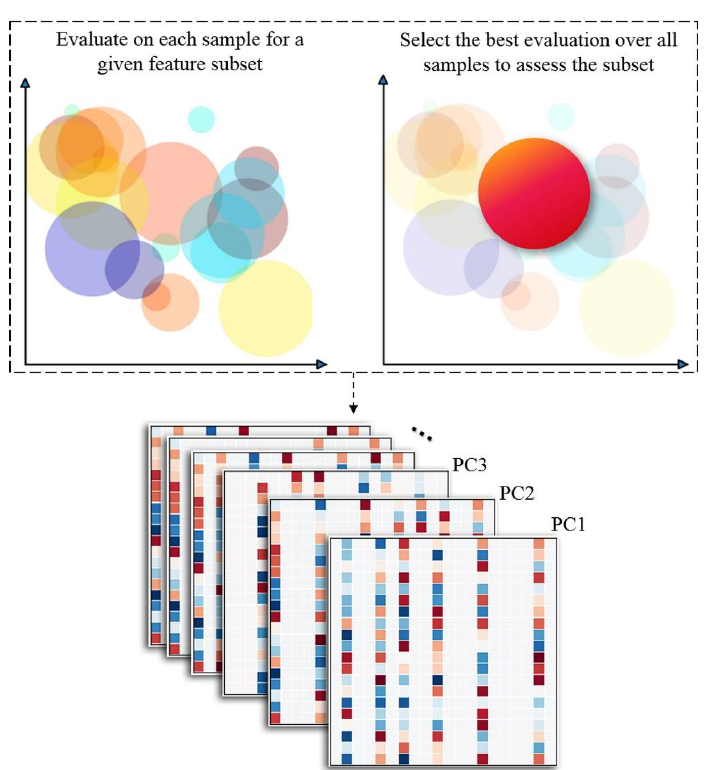
Figure 8. Description of LBS. For a given feature subset during training, LBS evaluates the loss function on each sample and optimizes the radius automatically. The best, rather than the summation, of evaluations is then selected as metric of assessing the feature subset. The final LBS model consists of multiple PCs, and each PC is a sparse combination of features.